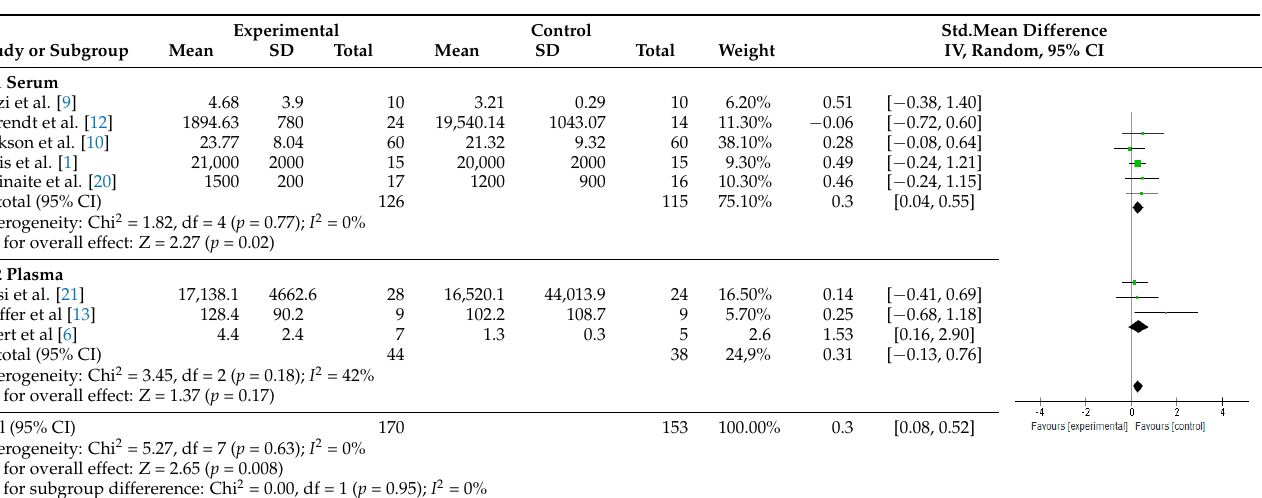
Heterogeneity: Chi² = 5.27, df = 7 ( p = 0.63); I ² = 0% Test for overall effect: Z = 2.65 ( p = 0.008) Test for subgroup differerence: Chi² = 0.00, df = 1 ( p = 0.95); I ² = 0%